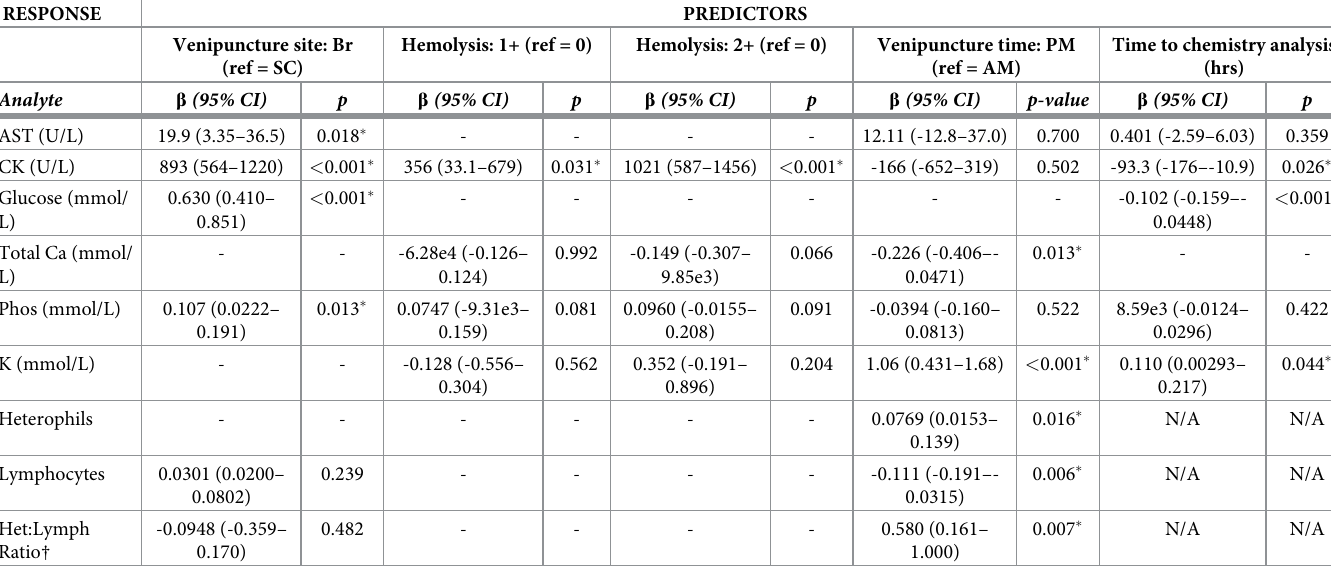
Results presented are the average of the best fit univariate generalized linear models ( Δ AICc < 2) for each response analyte. Only models containing statistically significant predictors are presented. Br = brachial, AST = aspartate transaminase, Ca = calcium, CI = confidence interval, CK = creatine kinase, K = potassium, Na = sodium, p = Wald Z p-value, Phos = phosphorus, ref = reference value of categorical predictors, SC = subcarapacial,— = analyte not included in best fit model(s) � = p < 0.05, † = analyte log